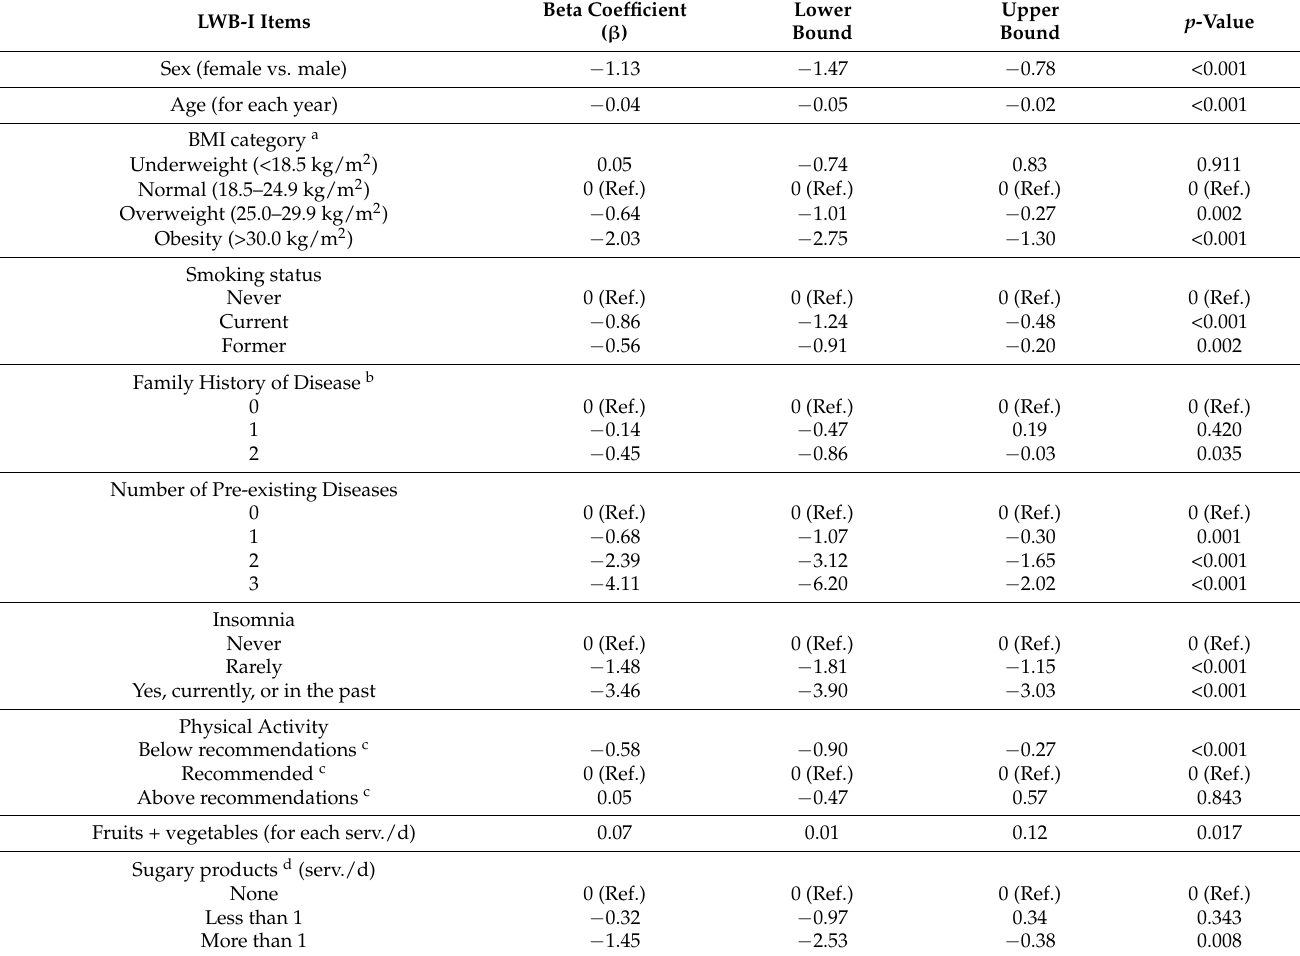
Table 2. Multivariate linear regression models using total SF-33 scores (range from 0 to 100) as the outcome. Description of β -Coefficients (difference in SF-33 for each unit of the independent variable). All variables used to develop the Lifestyle and Well-being Index are included in The SUN